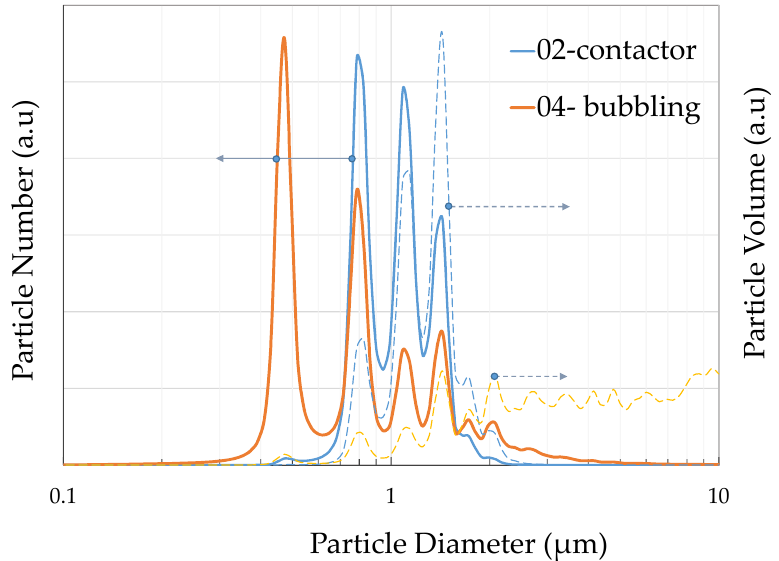
Figure 6. Sample PSD derived by DLS as a function of particle number (solid line right axis) and particle volume (dotted line, left axis) for the contactor and bubbling mode samples. Table 4. Number-based diameter parameters (Dn 10%, 50%, 90%) and volume-based diameter parameters (Dv 10%, 50%, 90%) of samples in contactor and bubbling mode.